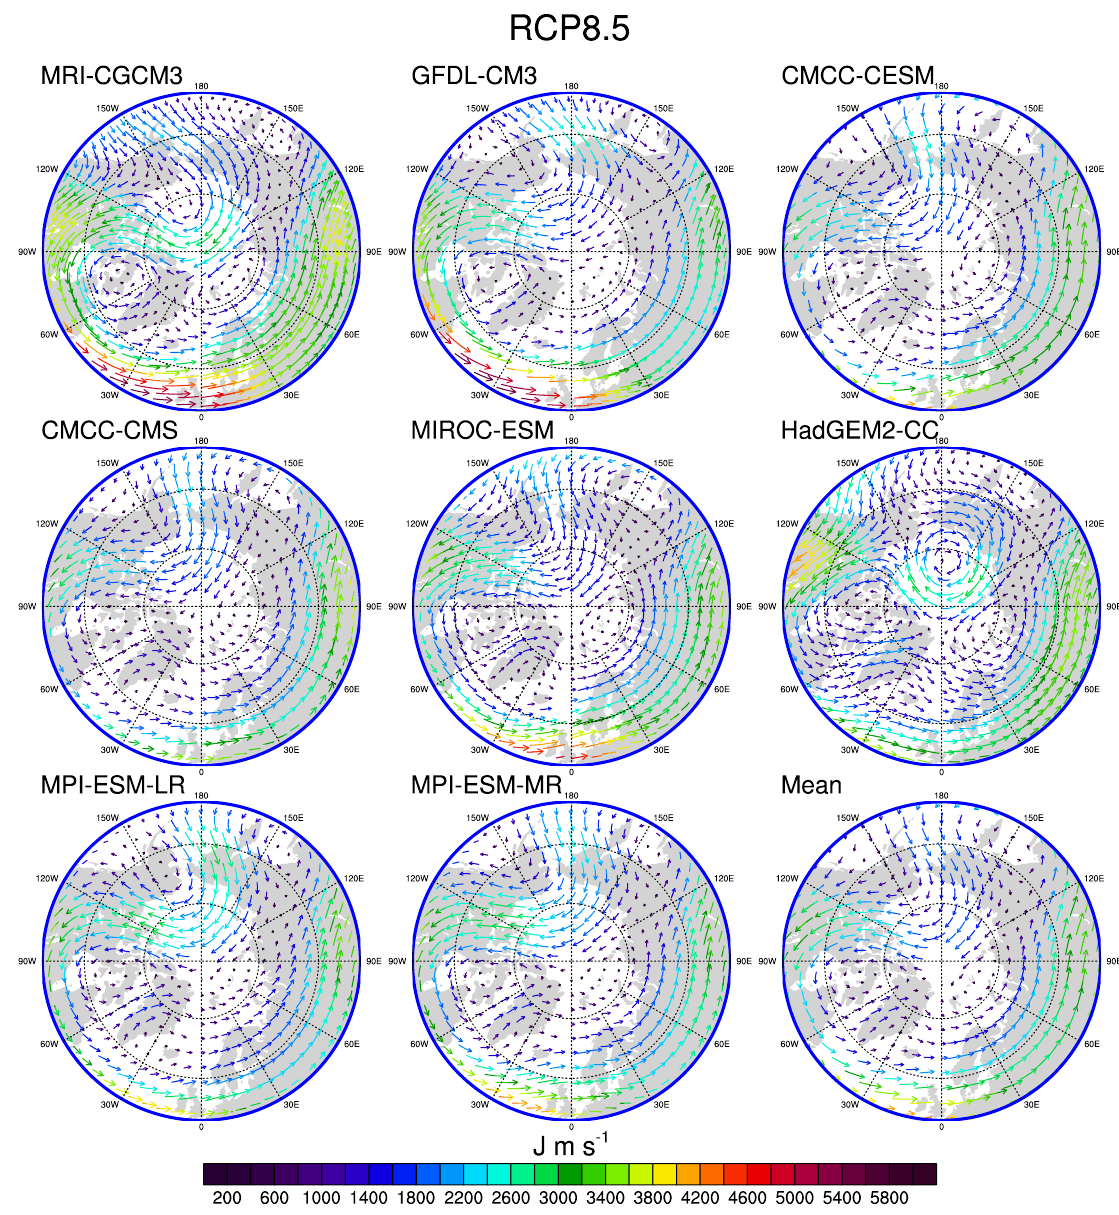
Figure 7. Same as in Figure5, but for the Pacific